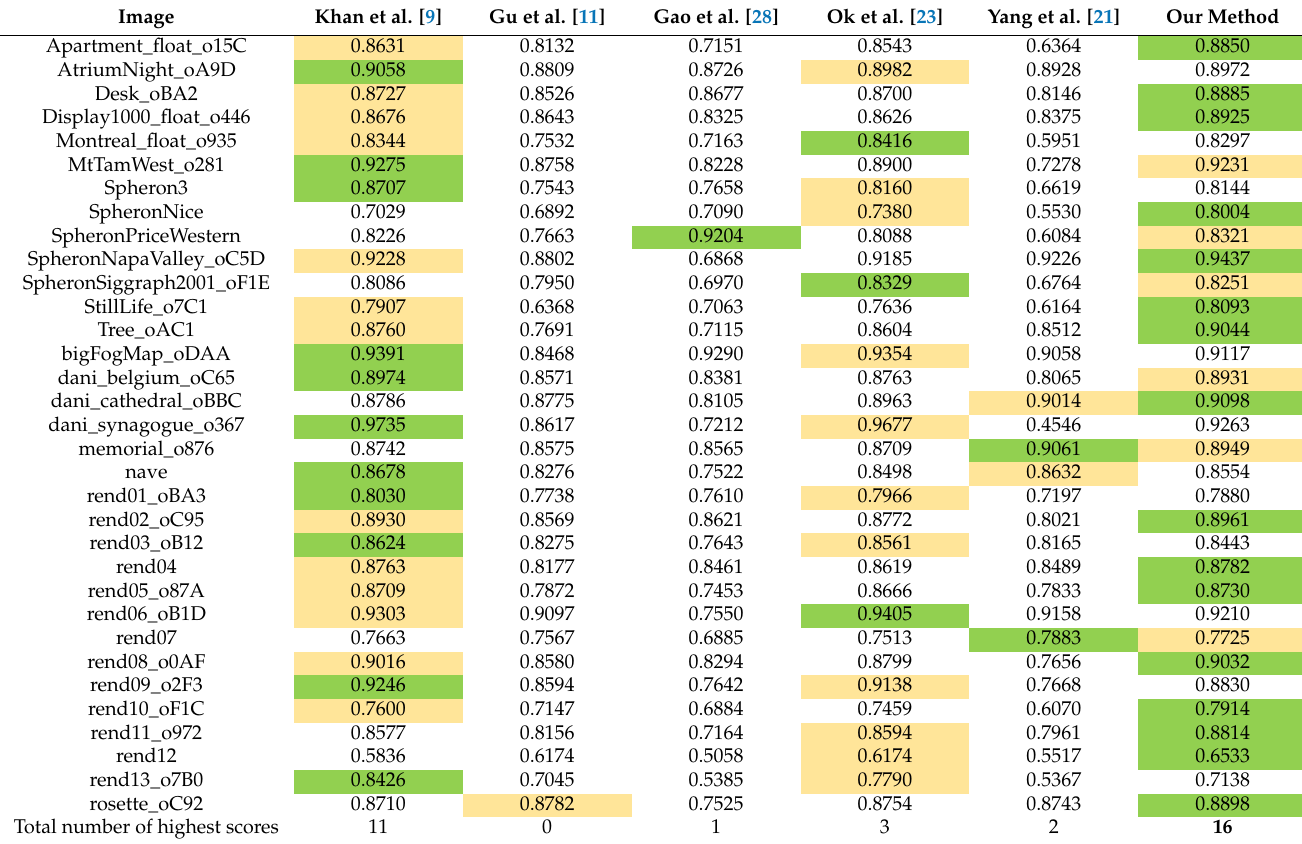
Table 2. TMQI-S score of images from the dataset from [29] and the total number of highest scores for each method.